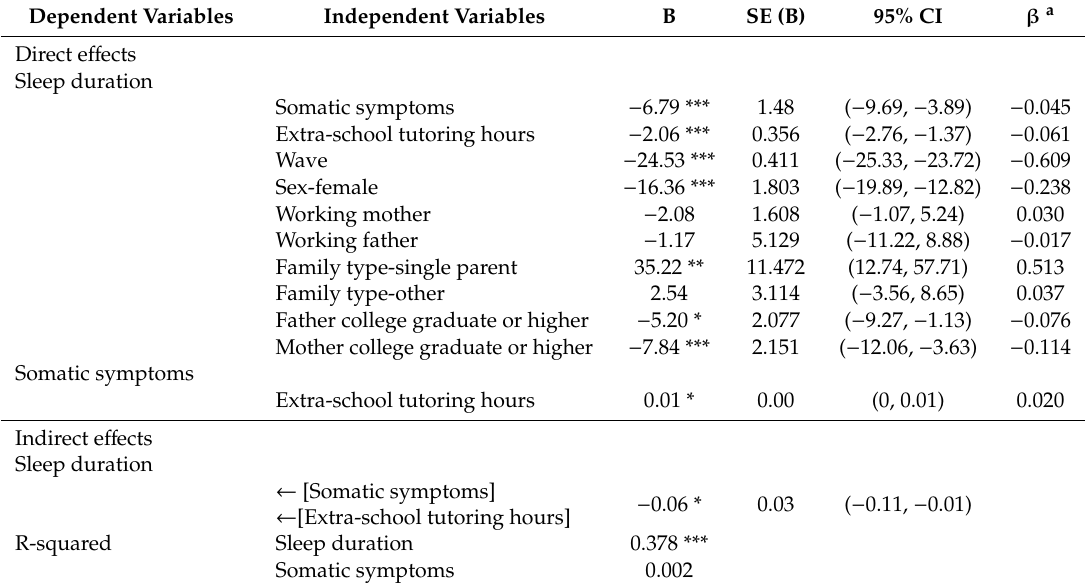
Table 2. Multilevel structural equation model results: relationships between extra-school tutoring time, somatic symptoms, and sleep duration of adolescent students.